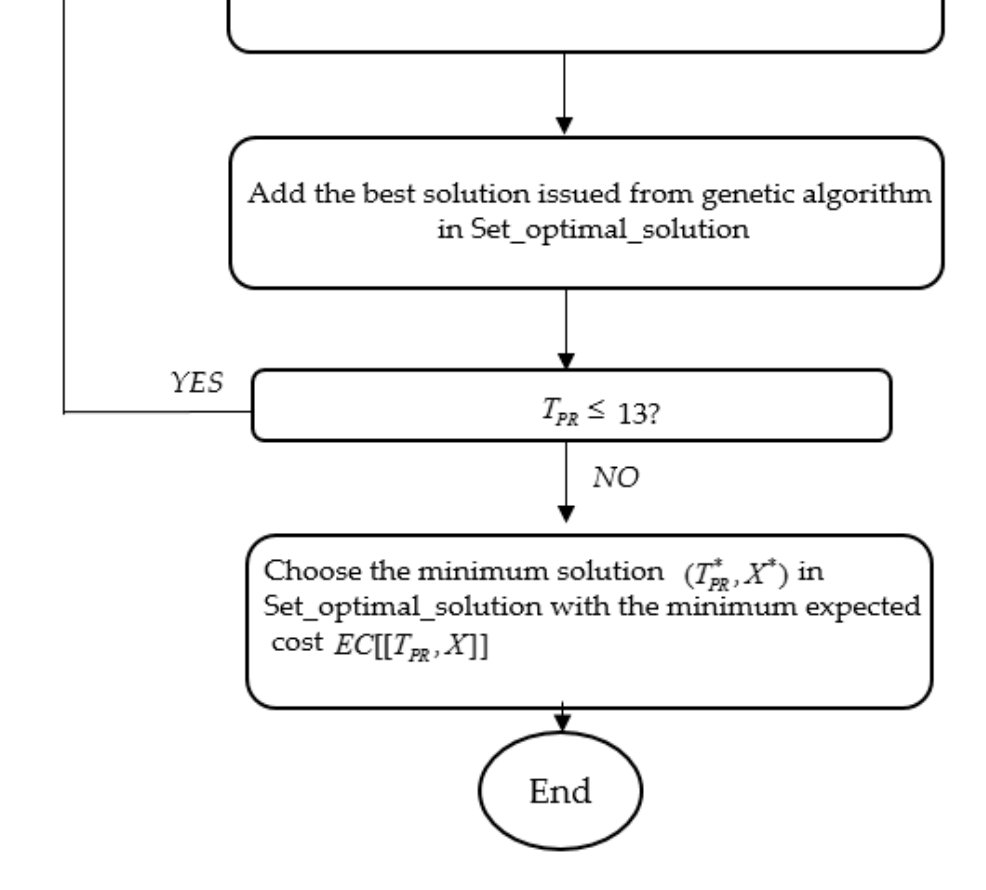
Figure 6. Flowchart of the proposed algorithm.